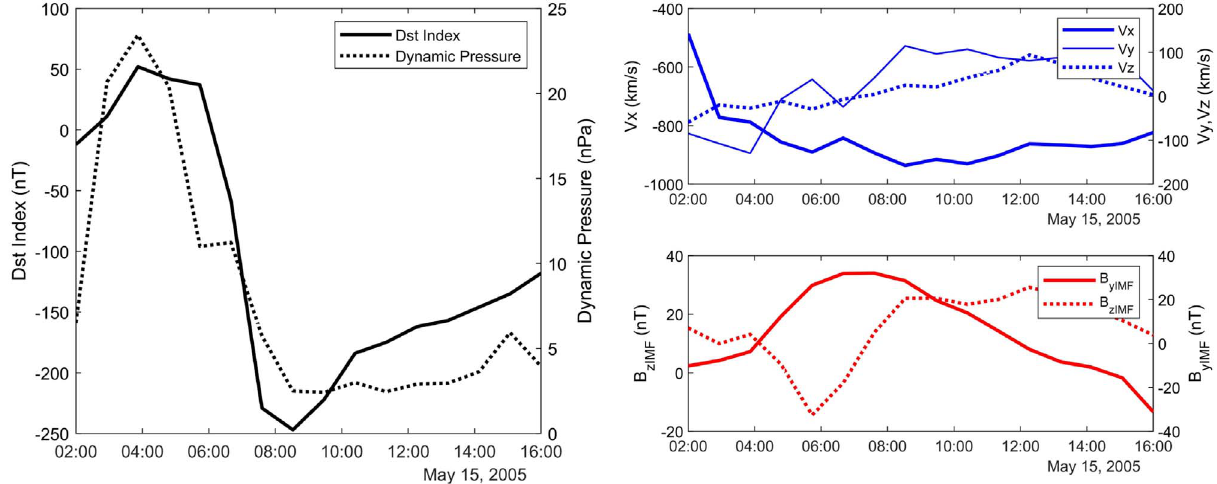
Fig. 1. The fi gure demonstrates the input space weather data during the geomagnetic storm: Dst index, solar wind dynamic pressure, solar wind three velocity components, and IMF transversal